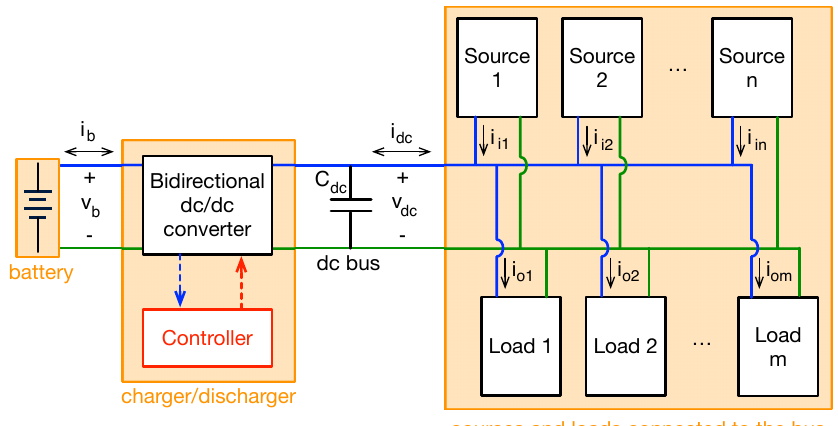
Figure 1. General structure of a DC